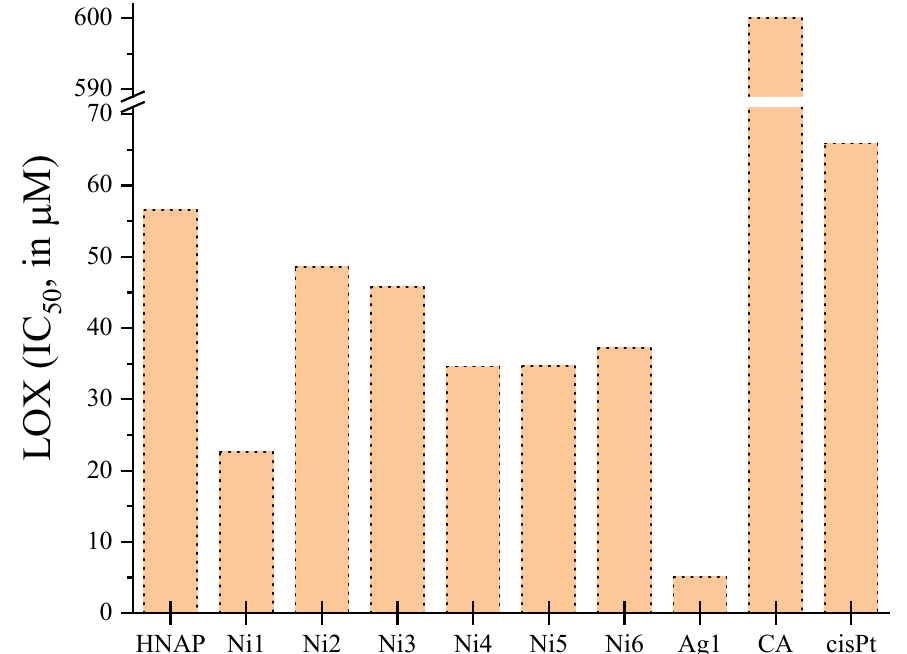
Figure 27. LOX inhibitory activity (IC 50 in µ M) of naproxen and its reported complexes. (Codes of compounds: HNAP = naproxen; Ni1 = [Ni(NAP) 2 (CH 3 OH) 4 ]; Ni2 = [Ni(NAP) 2 (bipy)(CH 3 OH)]; Ni3 = [Ni(NAP) 2 (phen)(H 2 O)]; Ni4 = [Ni(NAP) 2 (bipyam)]; Ni5 = [Ni(NAP) 2 (Hpko) 2 ]; Ni6 = [Ni(NAP) 2 (py) 2 (H 2 O) 2 ]; Ag1 = [Ag(PPh 3 ) 3 (NAP)](H 2 O); CA = caffeic acid and cisPt =